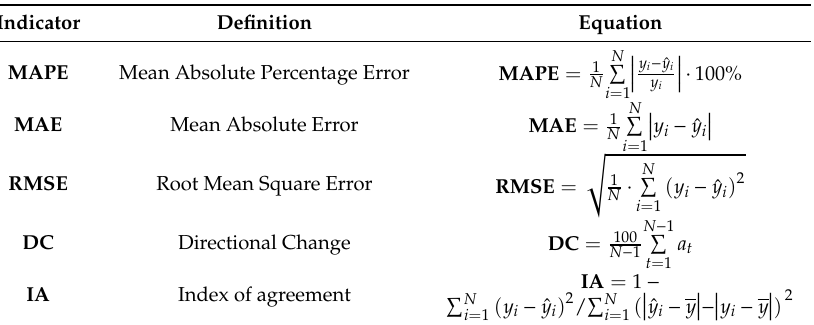
Table 3. Point forecasting evaluation metrics.